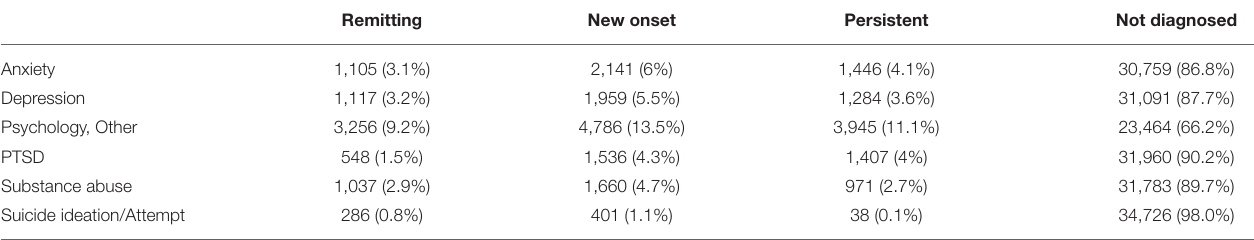
TABLE 2 | Proportion of service members with mental health conditions.